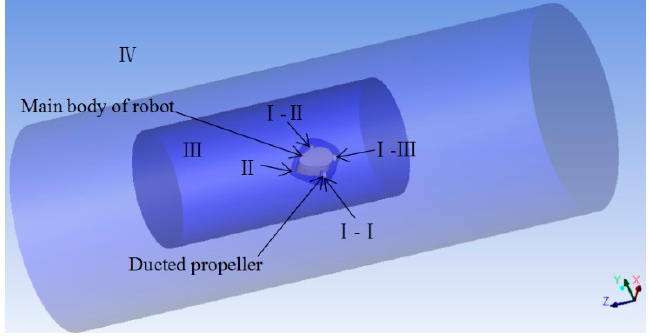
Figure 11. Computational domains of the underwater robot system.